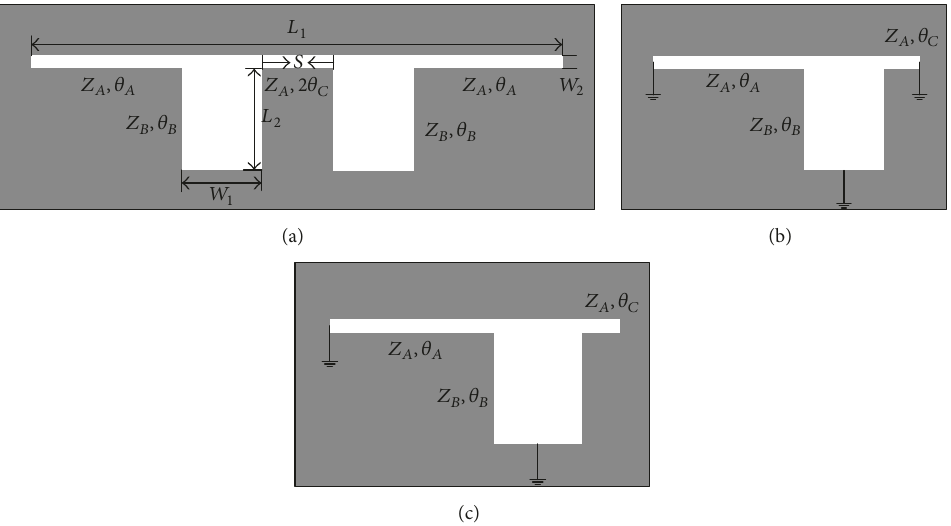
Figure 1: (a) Slotline MMR and its equivalent circuits (b) odd-mode and (c)